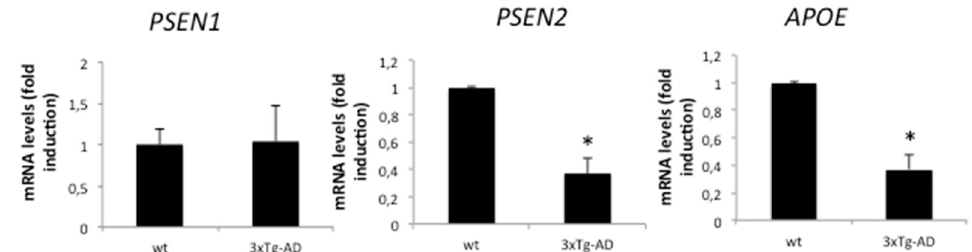
Figure 2. Changes in gene expression in APP/BIN1/COPS5 3xTg-AD mice. PSEN1, PSEN2, and APOE mRNA levels were analyzed in wild-type ( n = 4) and APP/BIN1/COPS5 3xTg-AD ( n = 4) mice. Data are expressed as mean ± S.E.M. and as fold-changes compared to mRNA levels in wild-type mice; * p < 0.05. APOE, apolipoprotein E, PSEN, presenilin.